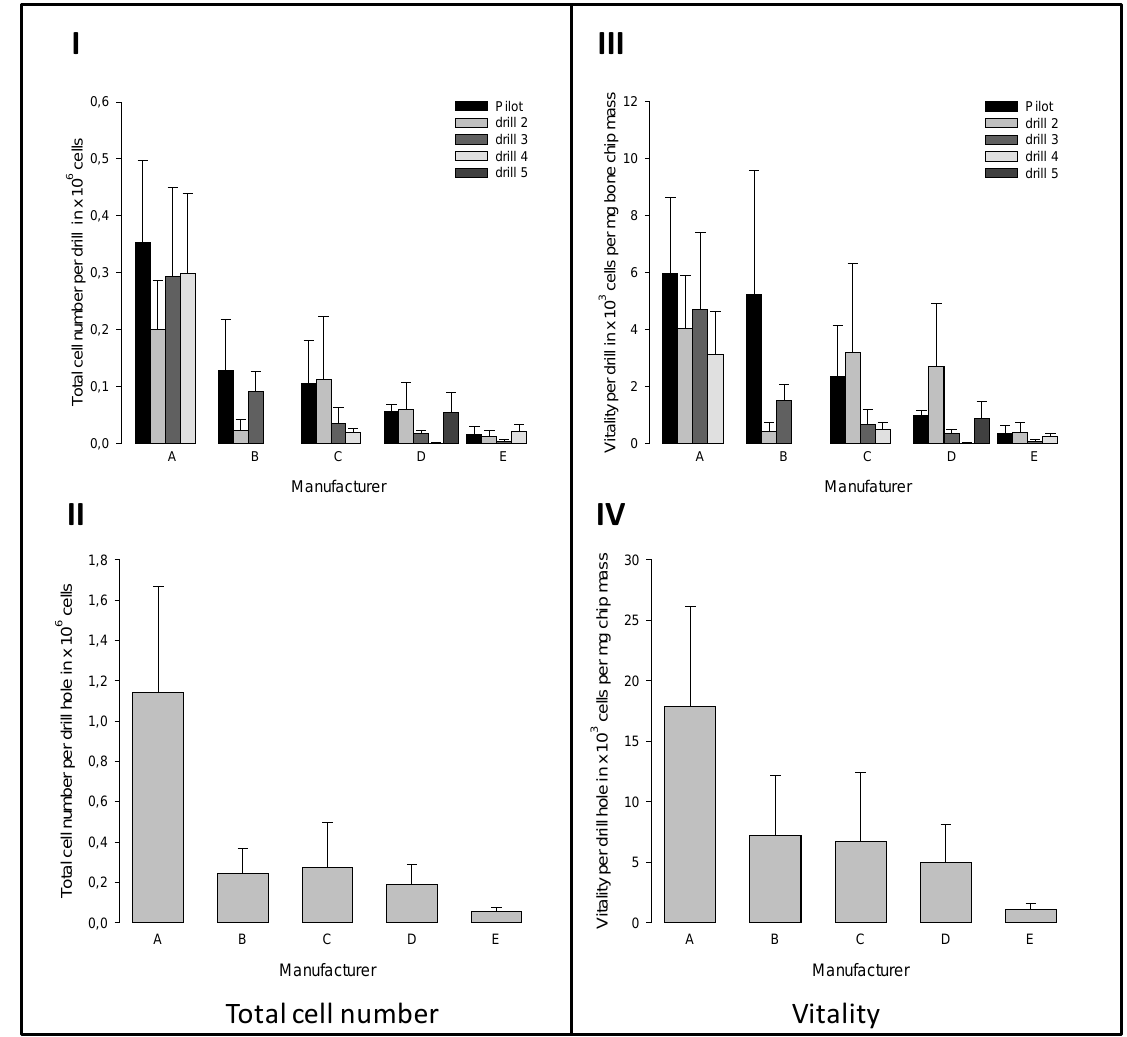
Figure 10. Total numbers of ( I , II ) outgrown cells and ( III , IV ) vitality of collected bone chips (displayed as number of outgrown cells per mg drilled bone chip mass). The upper row presents the results for each drilling tool of the five commercial implant drill sets ( I , III ). The lower row shows the sums for the respective drill sets ( II , IV ). (mean ± SEM; n = 3).